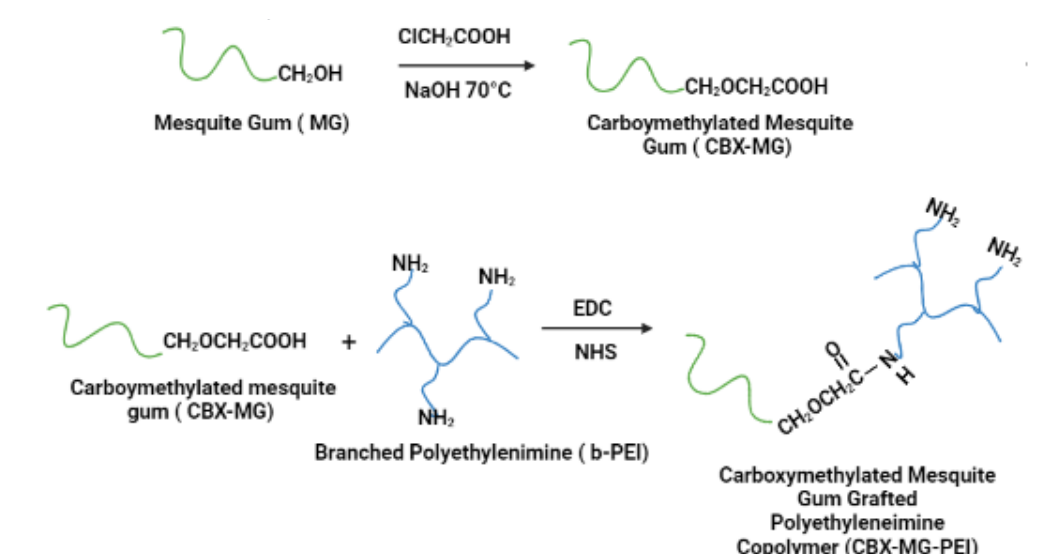
Figure 1. Schematic representation of carboxymethylation of mesquite gum and the modification of branched polyethyleneimine (b-PEI) with carboxymethylated mesquite gum (CBX-MG).